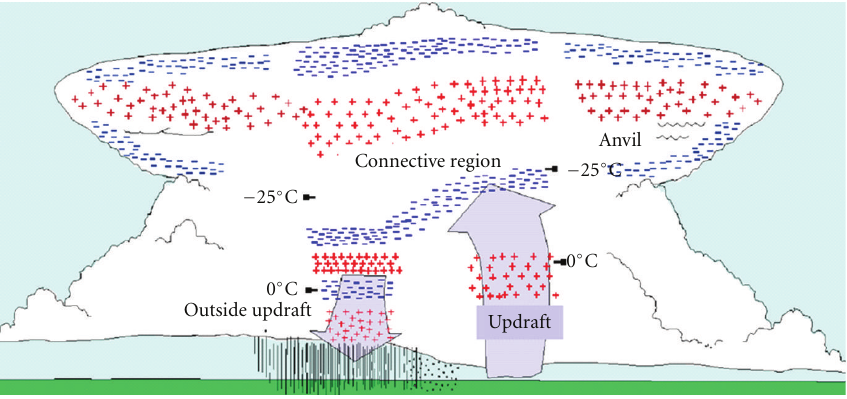
Figure 7: Conceptual model of the charge structure within an idealized isolated, mature thunderstorm based on 49 balloon sounding through di ff erent clouds, credit [22,